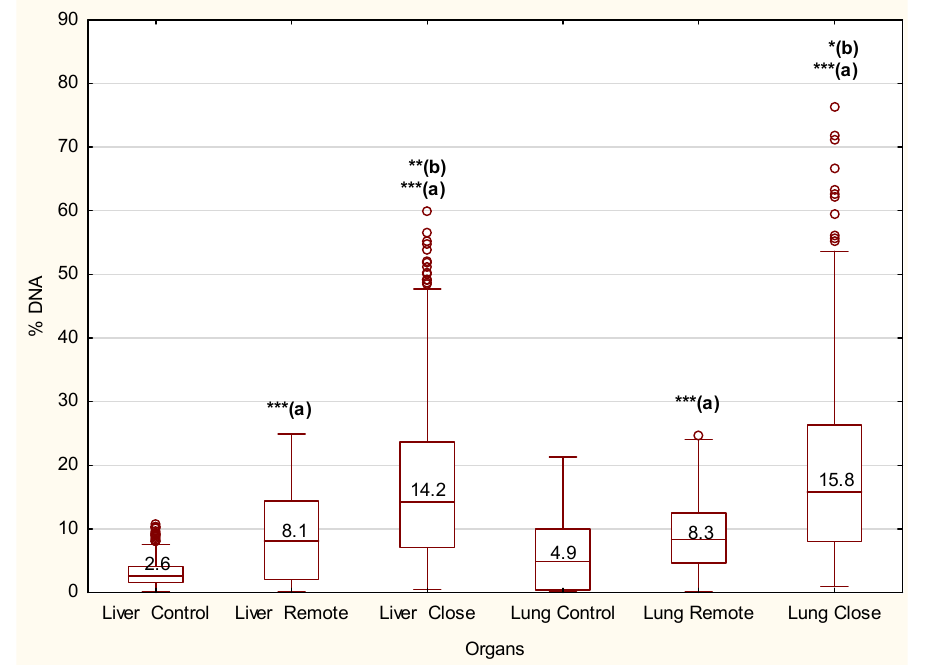
Figure 3. The percentage of DNA in the tail of the comet for the lung and liver cells of control and Paragonimus heterotremus - infected rats. Boxplots represent the median (line), 25–75% percentiles (box), and min ‐ max (whiskers). Asterisks (***, **, *) are indicative of significant differences from the corresponding control (a) or differences between remote and close to parasite capsule cells (b) ( p = 0.000, p = 0.0003, p = 0.005). Differences between replicates are statistically nonsignificant ( p = 1.0). Statistical differences were based on the Mann–Whitney U test. o represents outlier. Table 1. Genetic damage index (GDI) indices of the lung and liver cells in the control and Paragonimus heterotremus -infected